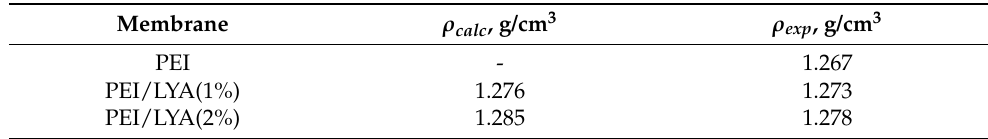
Table 1. Density of the membranes.